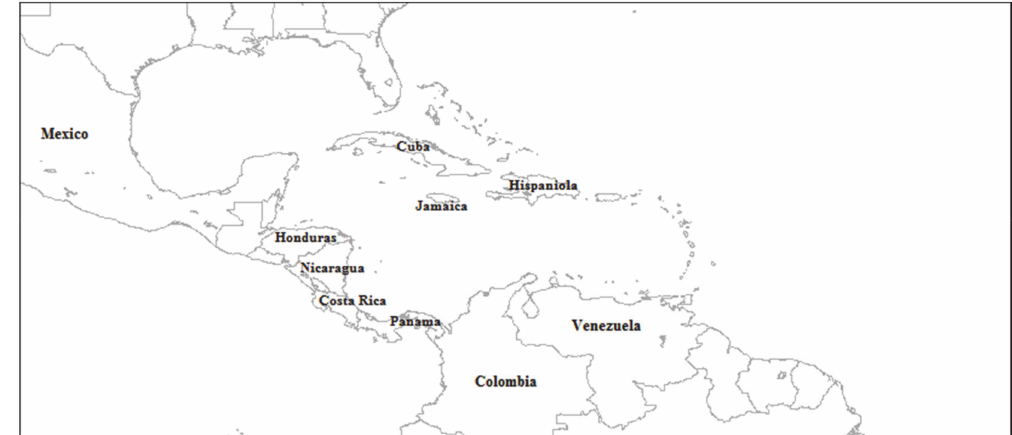
Figure 1. The Intra-America Seas including the Caribbean, Central America and northern South